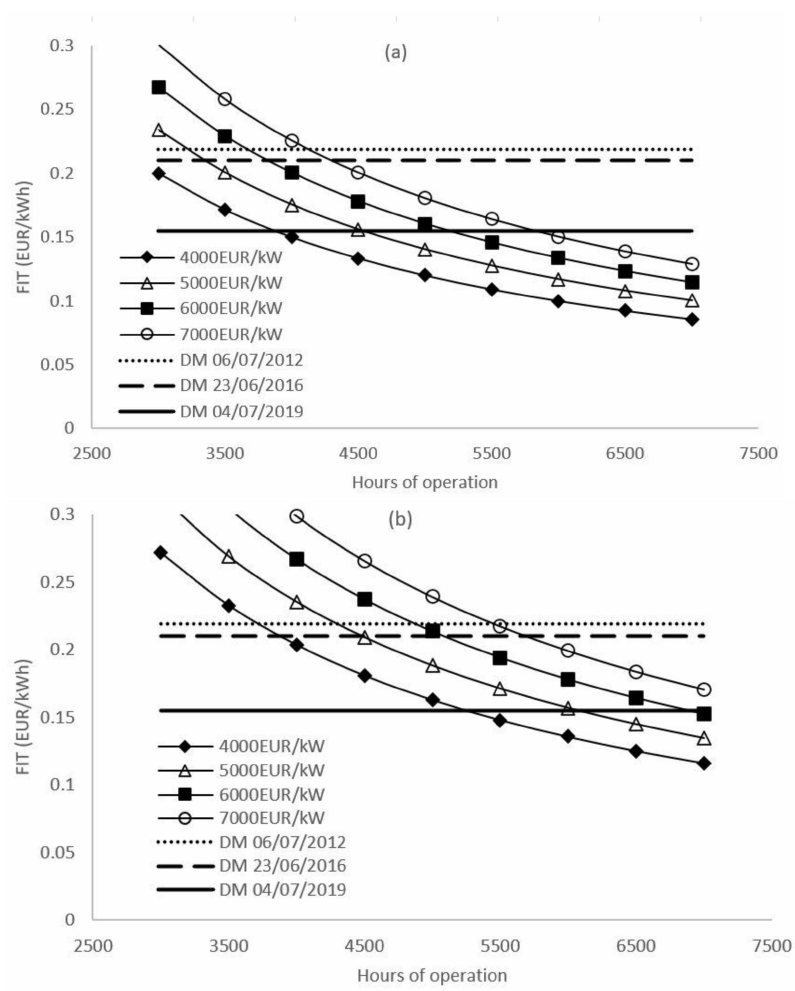
Figure 8. Feed in tariff vs. hours of operation for different capital expenditures to reach internal rate of return of 7% ( a ) and 9% ( b ); plant size is 250 kW.